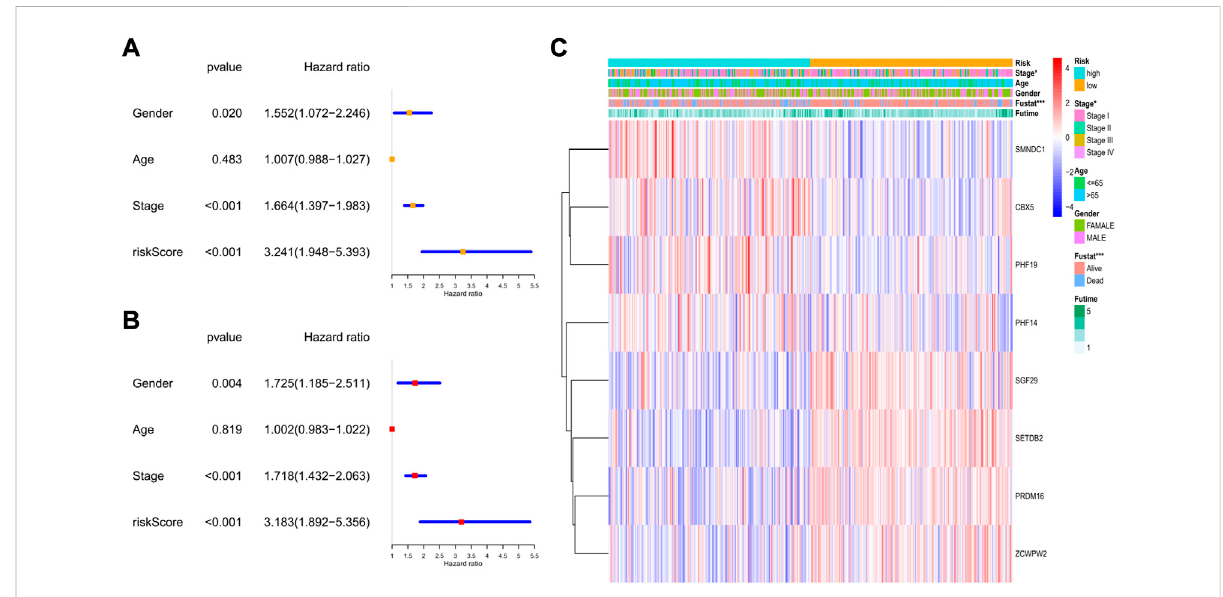
FIGURE 8 The independent prognostic value of the risk score in the validation set. (A) The forest plot for univariate analysis; (B) The forest plot for multivariate analysis; (C) The heatmaps for the gene expression combined with clinical characteristics.